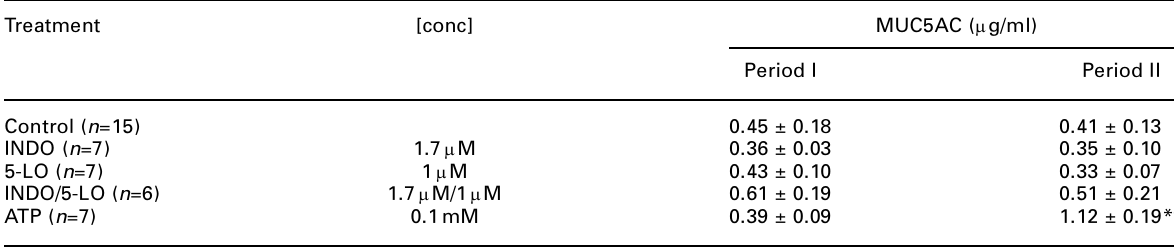
Table 1. Detection of MUC5AC in biological fluids derived from human airways in vitro : effects of INDOMETHACIN and 5-LIPOXYGENASE inhibition